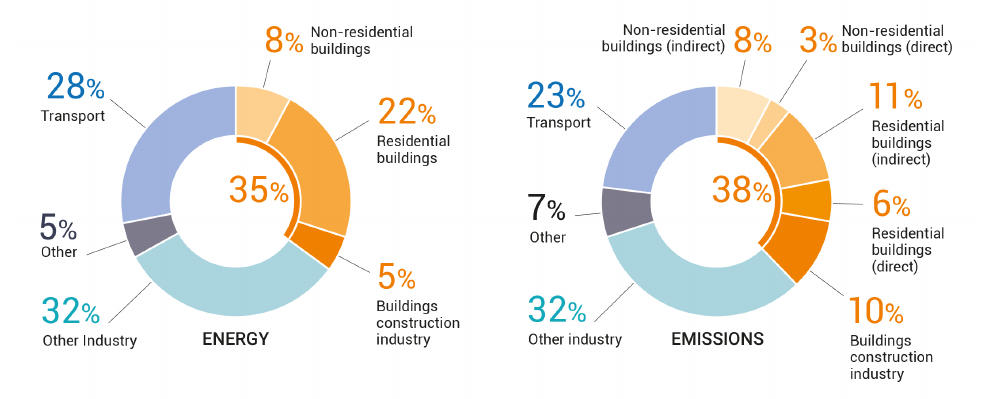
Figure 1. Global share of buildings and constructions based on their energy consumption and emissions [6–8].